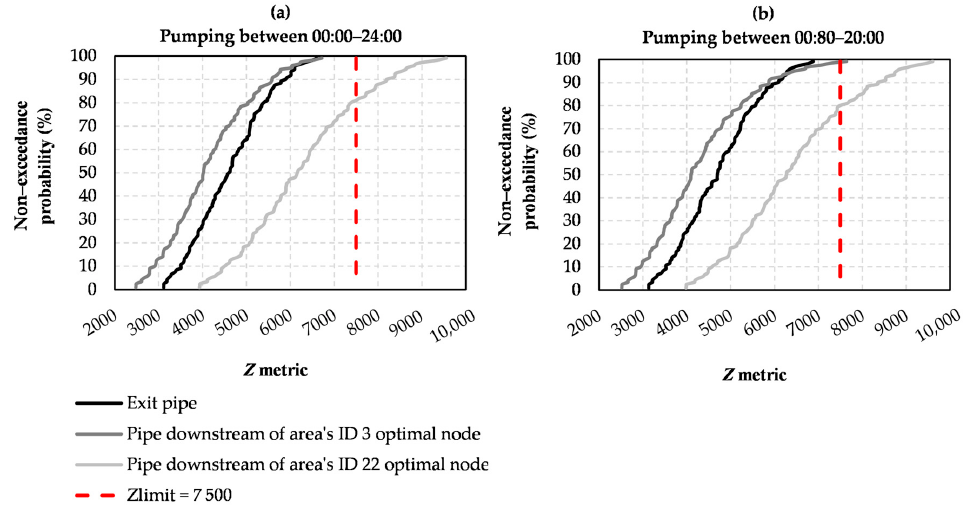
Figure 13. Comparison between twenty-four-hour and twelve-hour pumping of the same daily sewage amount regarding three network pipes. ( a ) The first panel concerns continuous pumping for a twenty-four-hour period and shows the non-exceedance probability that corresponds to a certain Z metric value with respect to three different pipes of interest; ( b ) The second panel concerns continuous pumping for a twelve-hour period and shows the non-exceedance probability that corresponds to a certain Z metric value with respect to the same pipes as the first panel.